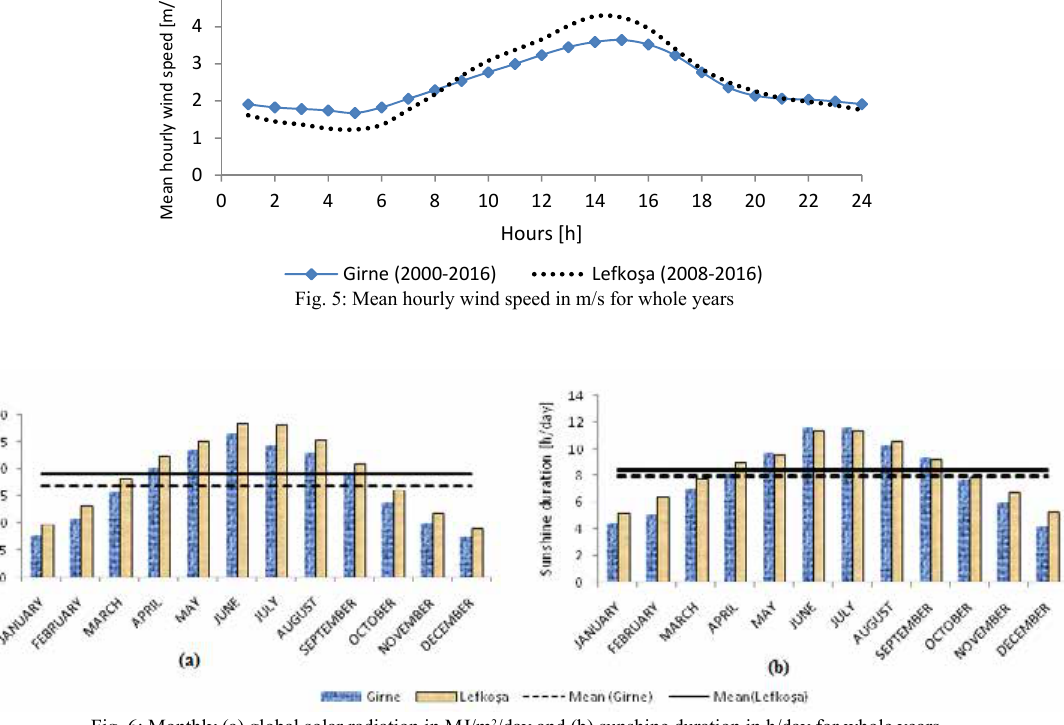
Fig. 6: Monthly (a) global solar radiation in MJ/m 2 /day and (b) sunshine duration in h/day for whole years